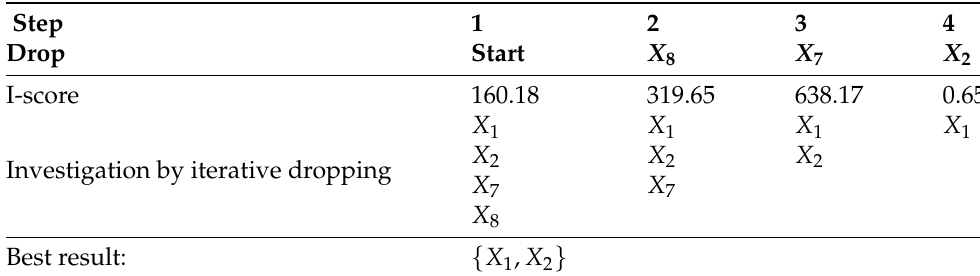
6 = 36 variables, × 6. We use a window size that is 2 2. × × 6 matrix, we create a new × 2 ×